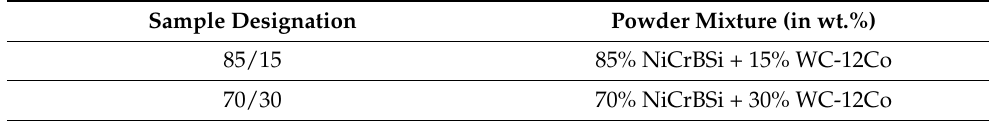
Table 1. Sample designation in respect to the powder